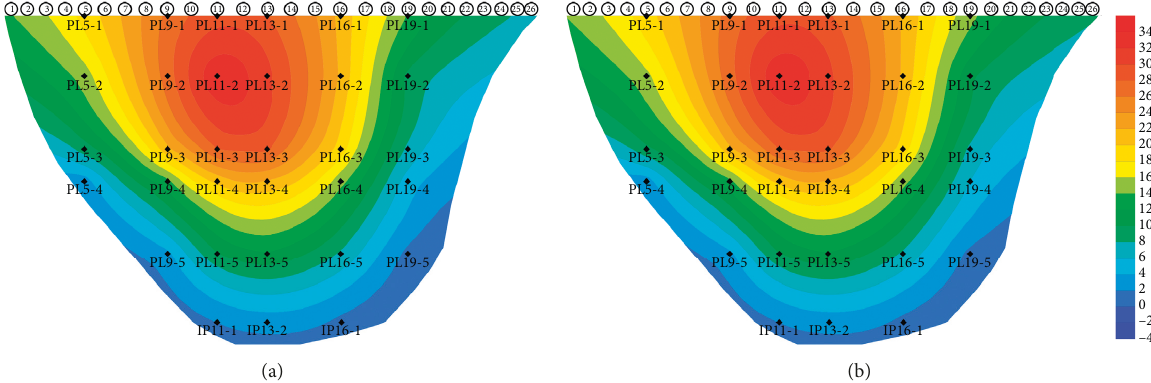
Figure 16: Comparison nephogram between the calculated radial displacement and that of the measured.